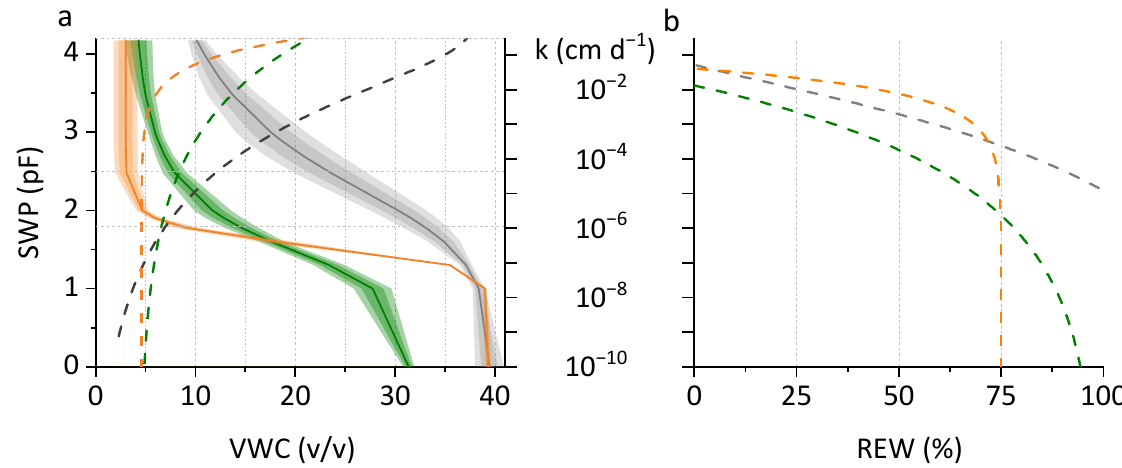
Figure 1. ( a ) Mean planting soil water retention curves (left y-axis) determined by pressure chamber, HYPROP, and field measurements in the three planting soils ‘Sand‘ (orange), ‘FLL‘ (green), and ‘Loamy Silt‘ (grey). SWP is the soil water potential and VWC is the volumetric water content. Shaded areas highlight the standard deviation (light) and the standard error (dark). Dashed lines show the log-transformed fitted hydraulic conductivity (k) (right y-axis) as a function of VWC determined by the HYPROP apparatus; ( b ) log-transformed fitted hydraulic conductivity (k) as a function of the REW (relative extractable water) determined by the HYPROP apparatus. Table 2. Soil properties of the three planting soils with OM as the organic matter content, BD as the bulk density, IC as the infiltration capacity, FC as the field capacity, and PAWC as the plant available water capacity.